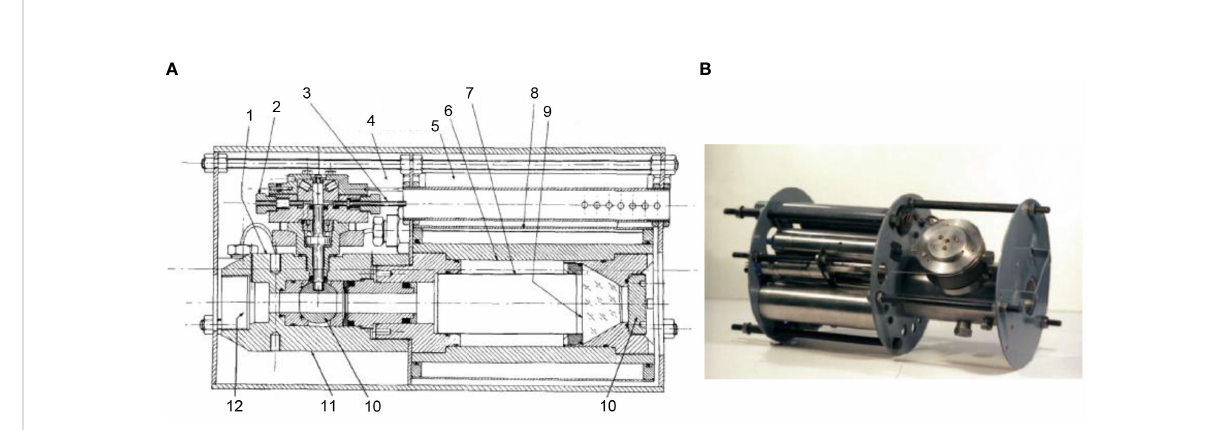
FIGURE 4 Schematic diagram and photo of High-pressure Trap (A) : 1: Valve;2: Stop;3: Trigger;4,5: Thermal Insulation;6: Bait chamber;7: Sample chamber;8: Water jacket;9: Viewing window;10: End plate;11: Globe vlave;12: Globe valve body;13: Entrance (B) Photo of High-pressure Trap [adapted from Macdonald and Gilchrist, 1978; Macdonald,